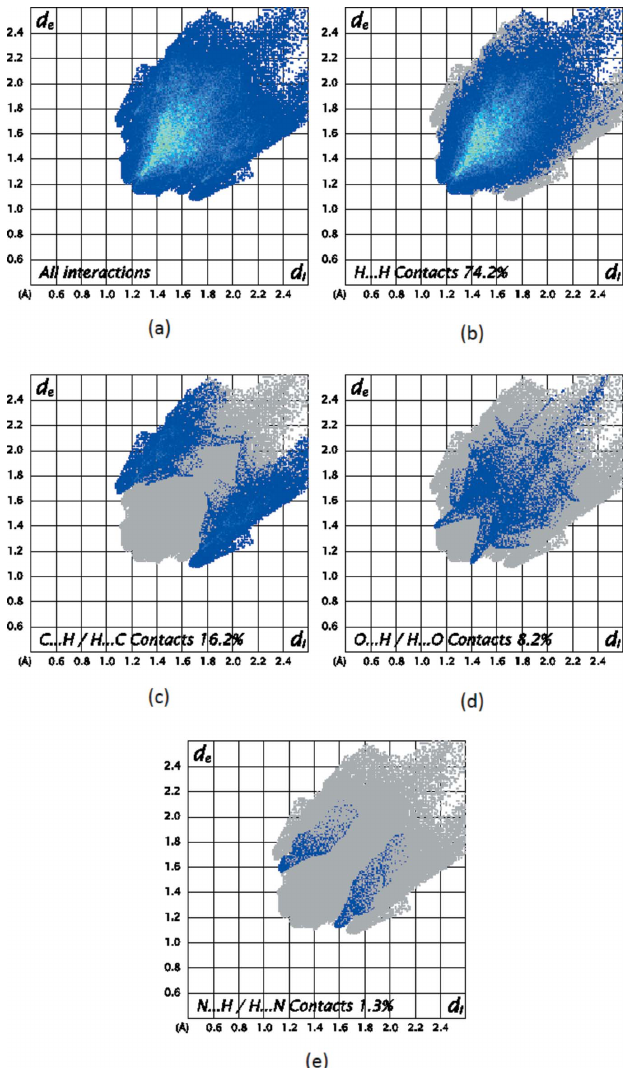
Figure 8 Two-dimensional fingerprint plots for compound (I), showing ( a ) all interactions, and delineated into ( b ) H (cid:2)(cid:2)(cid:2) H, ( c ) C (cid:2)(cid:2)(cid:2) H/H (cid:2)(cid:2)(cid:2) C, ( d ) O (cid:2)(cid:2)(cid:2) H/ H (cid:2)(cid:2)(cid:2) O and ( e ) N (cid:2)(cid:2)(cid:2) H/H (cid:2)(cid:2)(cid:2) N interactions. The d i and d e values are the closest internal and external distances (in A˚ ) from given points on the Hirshfeld surface.